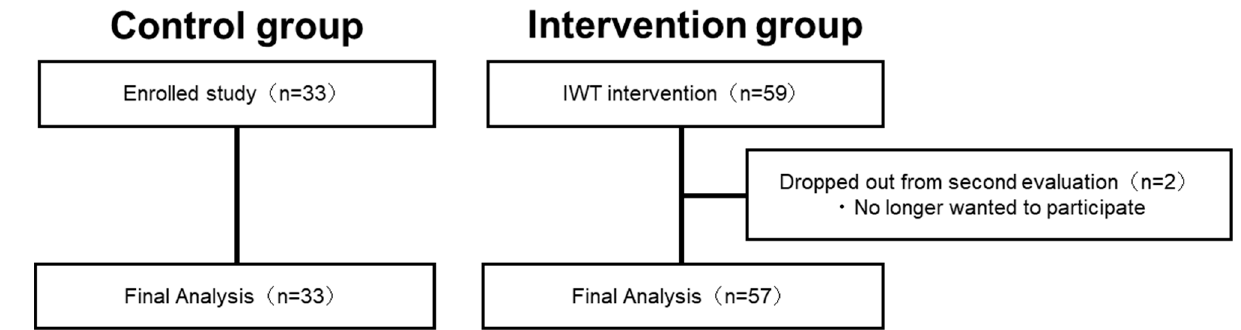
Figure 2. Flowchart showing the process of determining the final analysis participants. Table 1. Participant characteristics of each group before